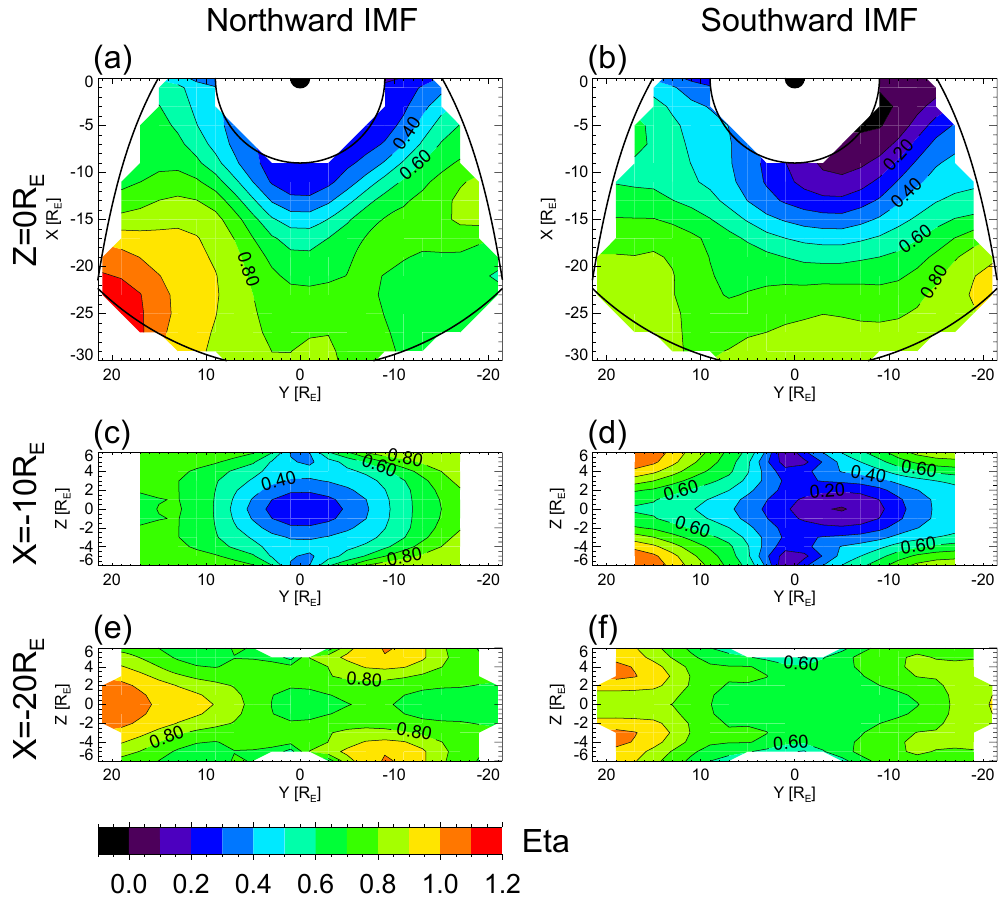
Fig. 4. Distributions of solar wind number density dependence parameter η for the northward and southward IMF conditions. Format is the same as Fig.